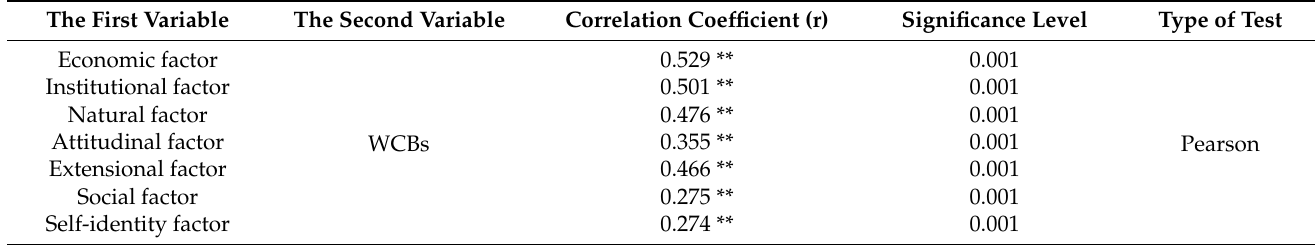
Table 7. The results of the correlation